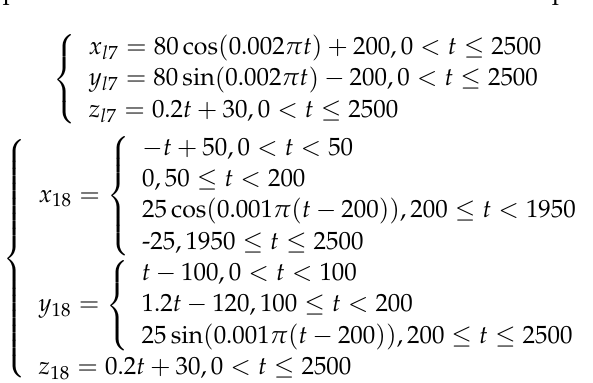
Table 3. The formation convergence time corresponding to different values of parameter γ . Parameter γ K 1 and K 2 The Time of Forming Formations Formation 1 Formation 2 γ = 1.8 K 1 = 0.0396 I 5 , K 2 = 0.8074 I 5 About 3.7 min About 7.8 min About 4.6 min About 9.6 min About 5.3 min About 12.4